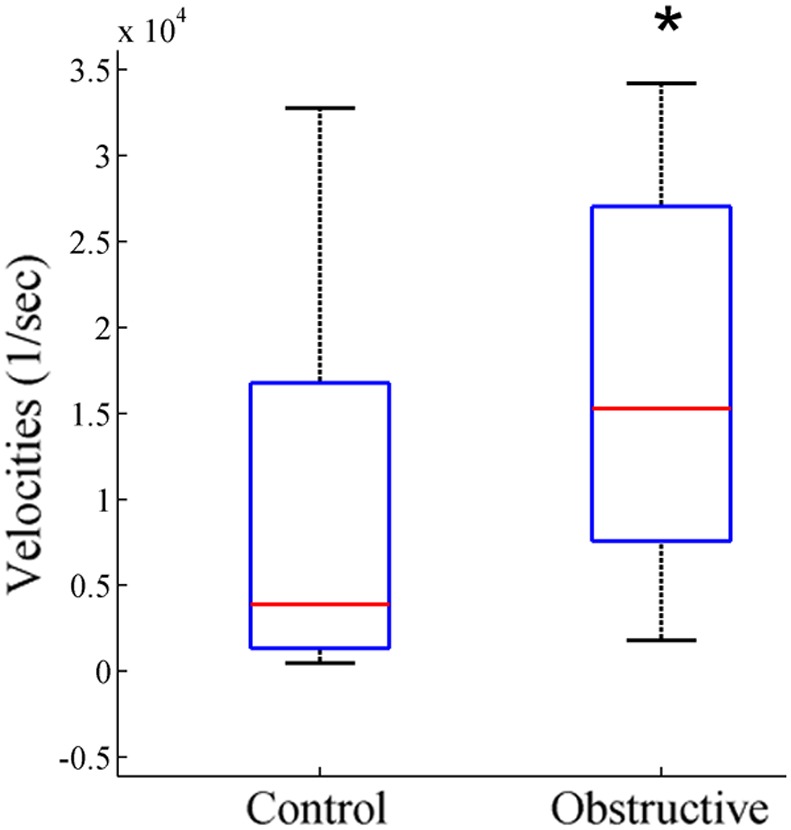
Box plot shows the median velocity of control and UAO groups following calculation of the sum of the velocities in each animal.*p<0.05.